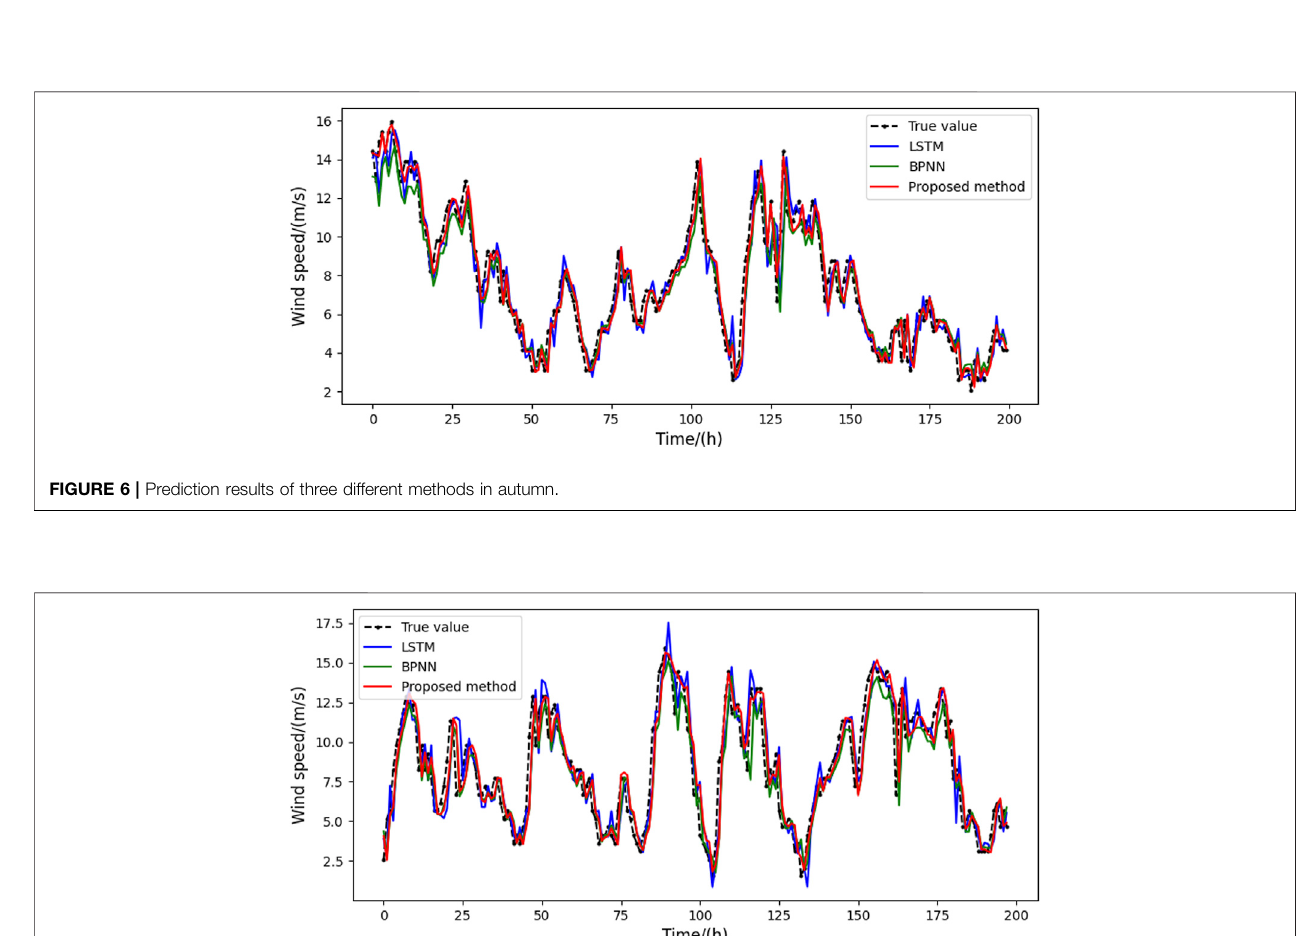
FIGURE 5 | Prediction results of three different methods in summer.